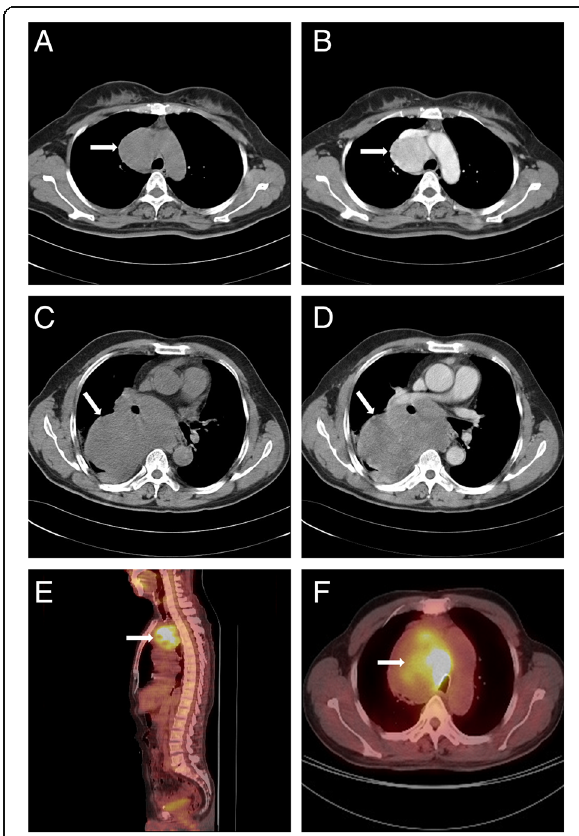
Fig. 1 Axial CT of case 1 shows a mass with distinct border in the right upper anterior mediastinum ( a ), which presents an obviously heterogeneous enrichment after enhancement ( b ). Axial plain ( c ) and enhanced ( d ) CT of case 2 reveal that in the right posterior mediastinum, there is a giant lobulated shadow with moderately heterogeneous enhancement. Sagittal ( e ) and axial ( f ) positron emission tomography and CT of case 3 indicate a mass in the middle mediastinum with avid fluorodeoxyglucose uptake